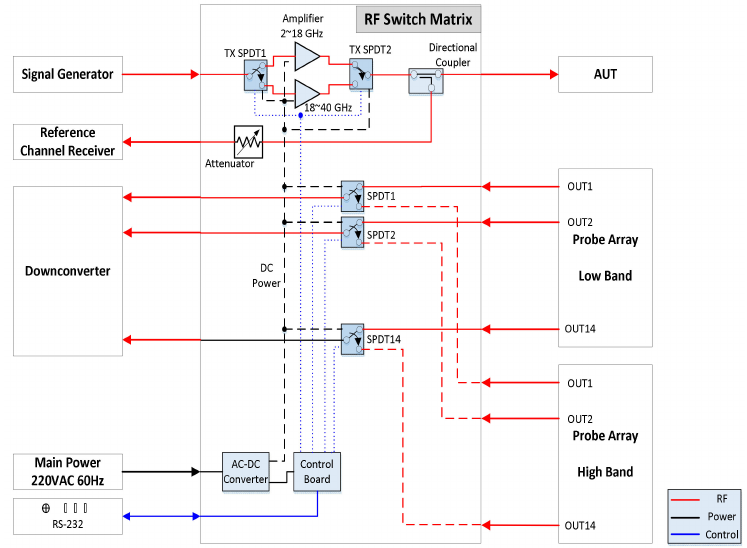
Figure 5. RF system block